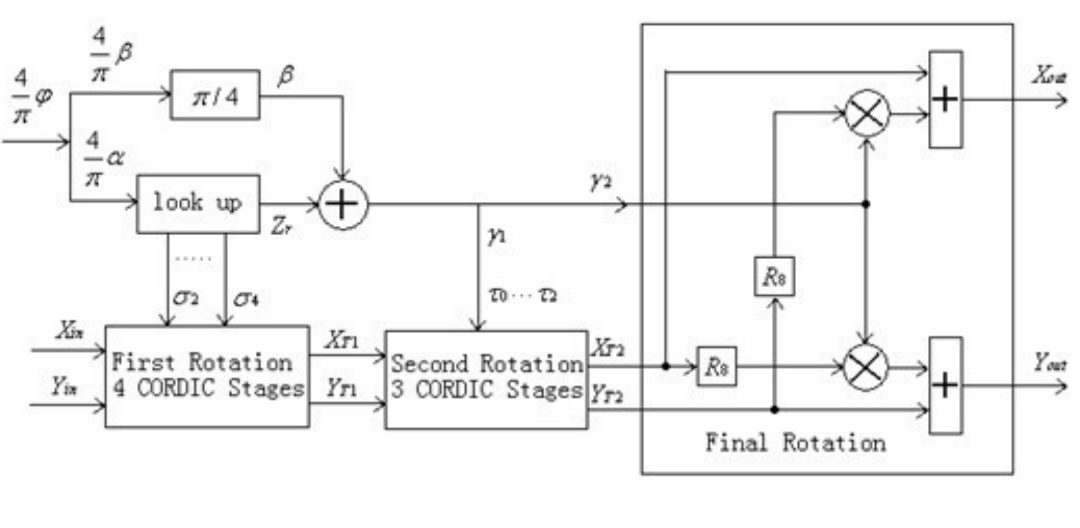
Fig. 3 the architecture of Hybird-CORDIC